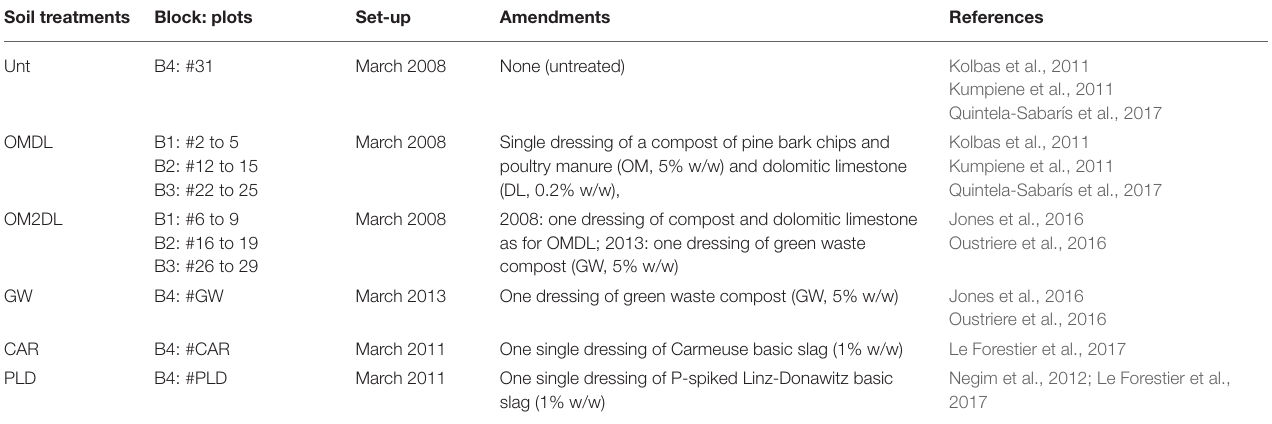
TABLE 1 | Soil treatments. Soil treatments Block: